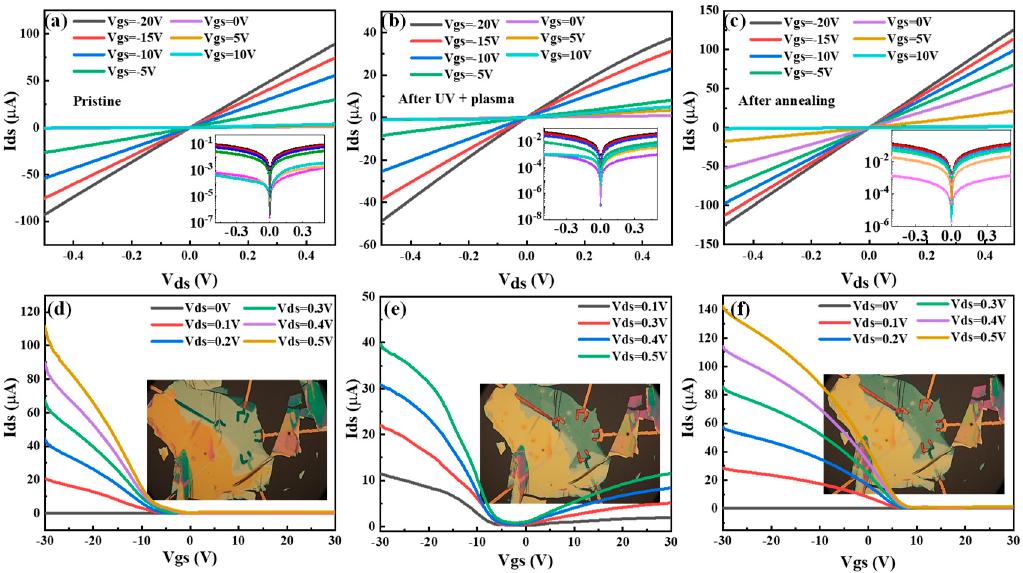
Figure 5. Current performance of BP flakes under different status which were tested at room tem- perature. I ds -V ds characteristics of BP FET at pristine ( a ), after thinning by 5 min light UVO and slight Ar + plasma treatment ( b ), and after 300 °C annealing in N 2 atmosphere ( c ), with V gs varying from − 20 V to 10 V. Insets are log-scale plots with unit A on the y-axes. I ds -V gs characteristics at pristine ( d ), after UVO and Ar + plasma treatment ( e ), and after annealing ( f ), with V ds varying from 0 V to 0.5 V. The insets are optical microscopy images of fabricated BP FETs under different treatments.